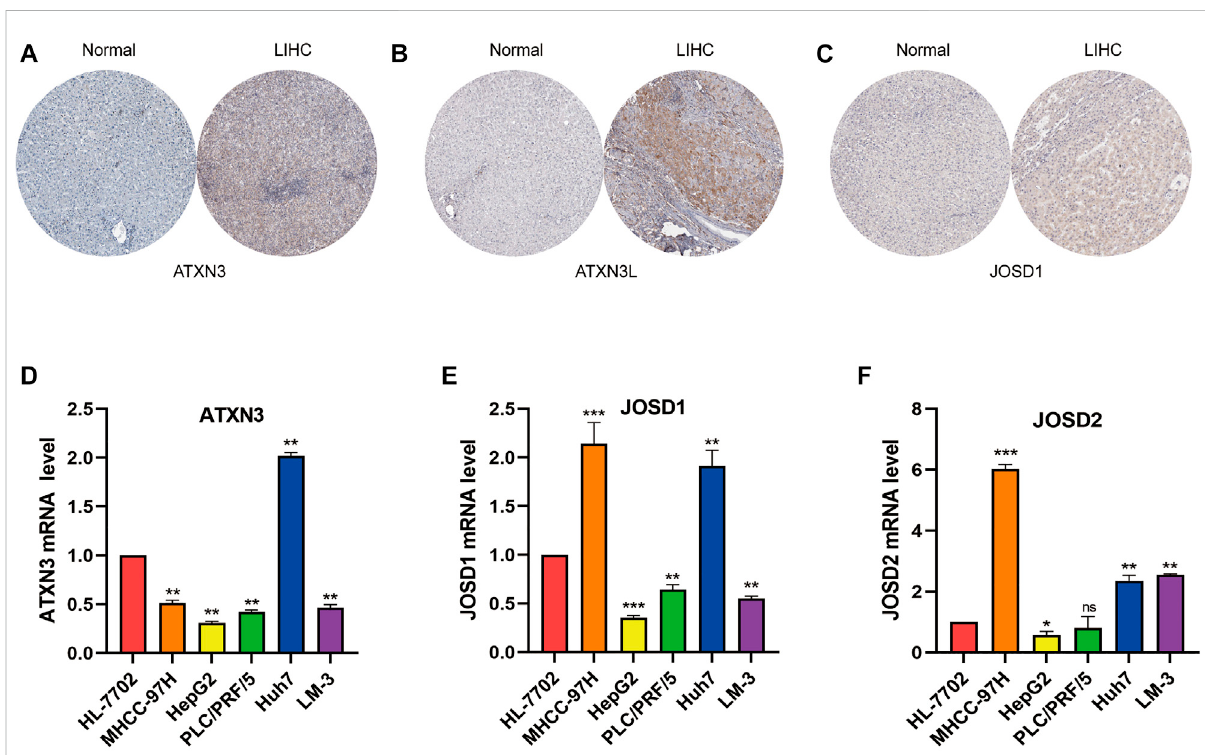
FIGURE 13 The expression levels of MJDs family members in HCC tissue and cell lines. The protein expression of (A) ATXN3, (B) ATXN3L, and (C) JOSD1 in HCC and normal liver tissues were obtained by immunohistochemical (IHC) data in the HPA database. The IHC image of JOSD2 was absent. The expression levels of (D) ATXN3, (E) JOSD1, and (F) JOSD2 in human immortalized HL-7702 and different HCC cell lines were conformed using RTqPCR.Ct values of ATXN3L were absent in HL-7702, MHCC-97 and HepG2 cell lines. * p < 0.05, ** p < 0.01, and *** p <